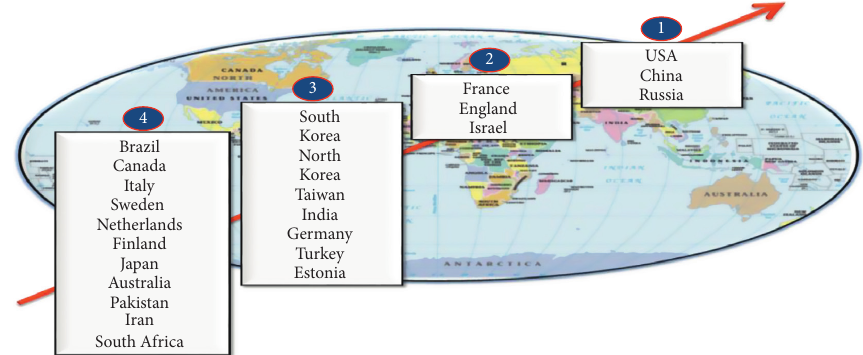
Figure 5: Situations of countries according to cyber power and capability